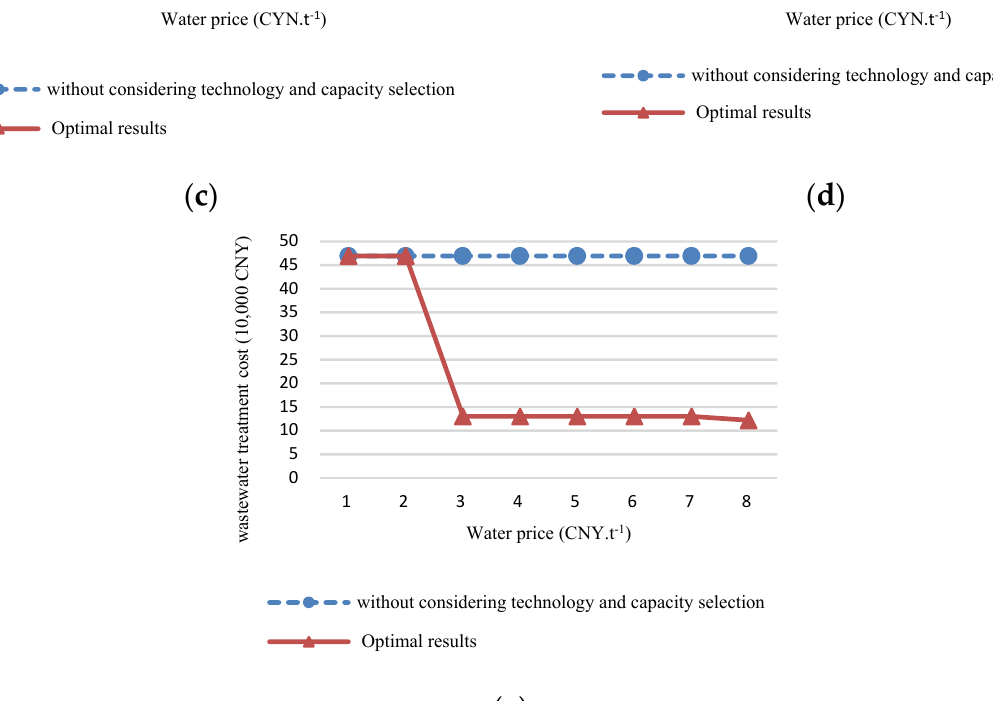
Figure 5. Cost comparison of desalination unit cost before and after optimization: ( a ) TAC; ( b ) basic operating cost; ( c ) investment cost; ( d ) operating penalty; ( e ) wastewater treatment cost. Table 5. Optimal operation scheme under different water price (Scenario 1).